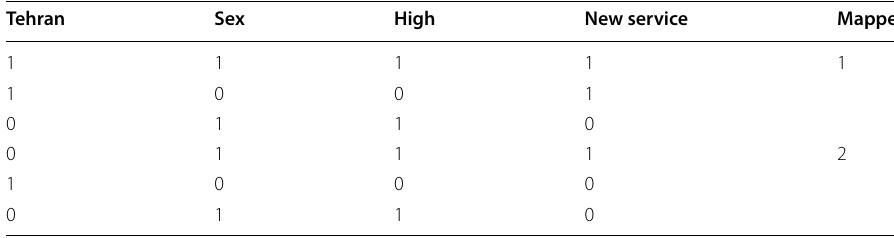
Table 3 Binominal